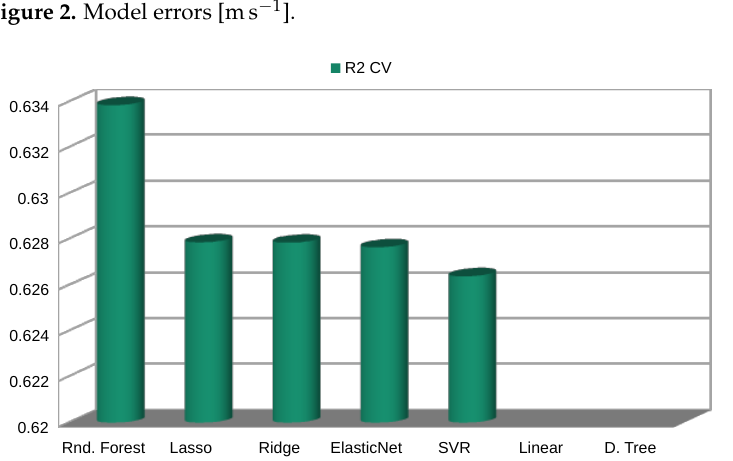
Figure 3. Performance